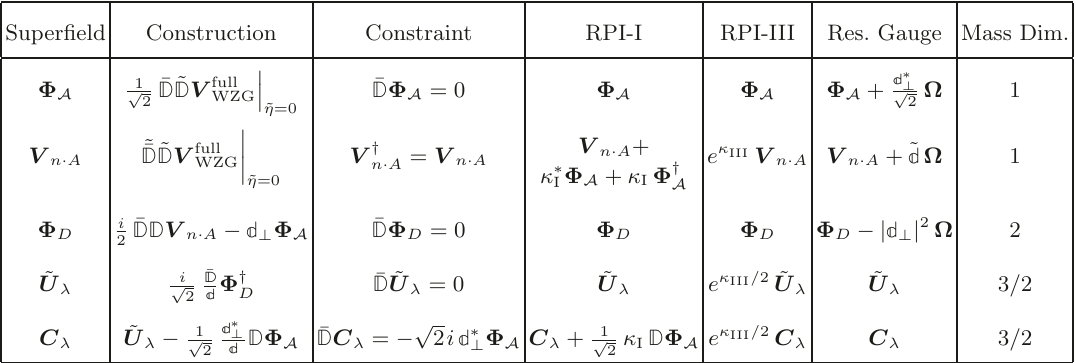
Table 5 . Collinear superfields for the Abelian gauge theory, along with their top-down construc- tion and transformation properties. Note that we are working in both WZG and LCG, in